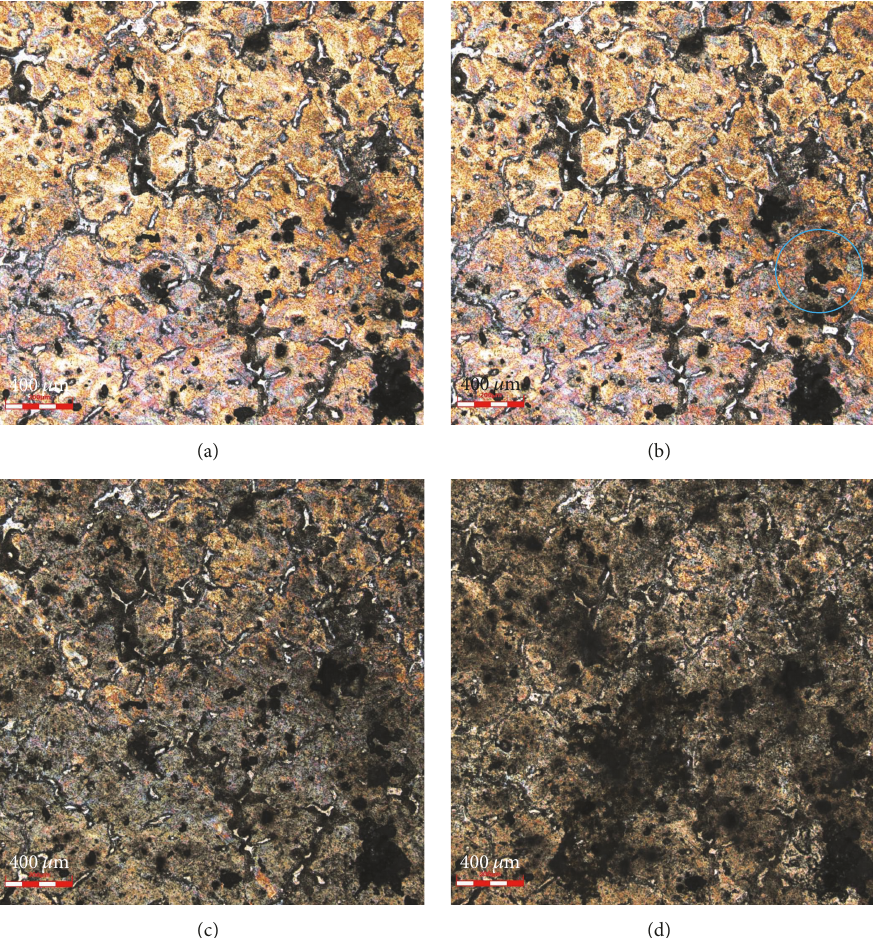
Figure 7: CLSM micrographs of the AZ91D alloy immersed for different times in 3.5 wt.% NaCl solution at room temperature: (a) 6 h; (b) 15h; (c) 40h; (d) 72